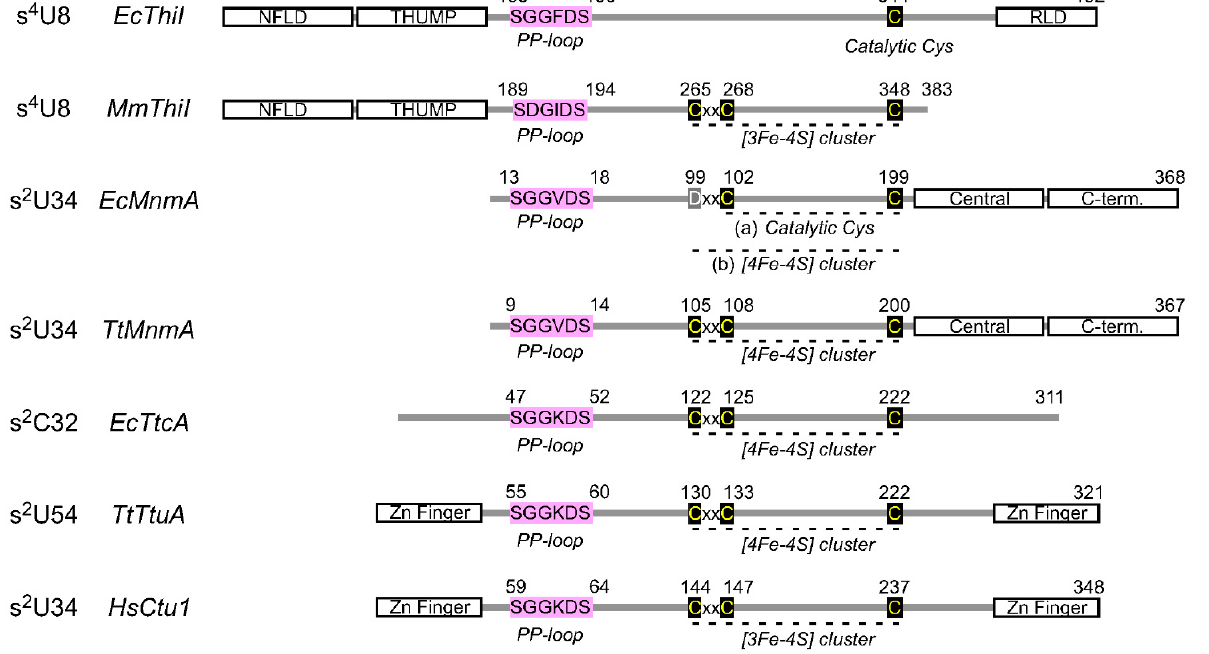
Figure 3. Domain organization of tRNA uridine/cytidine sulfurtransferases. The conserved residues in the active domain (center) and the accompanying RNA-binding domain are shown. Ec, Escherichia coli ; Mm, Methanococcus maripaludis ; Tt, Thermus thermophilus ; Hs, Homo sapiens . For EcMnmA, two possibilities are depicted (see text for details).